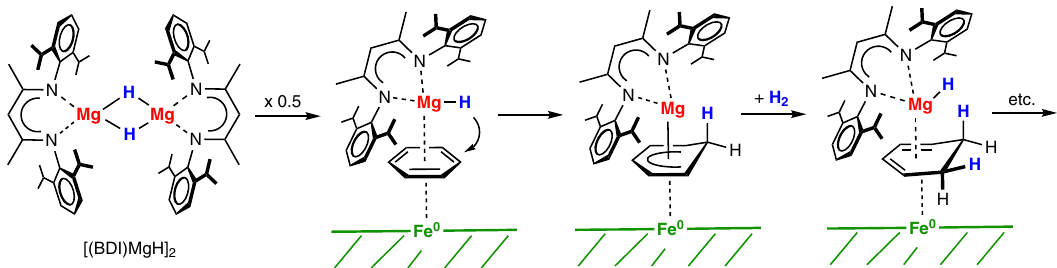
Fig. 5 Proposed mechanism for cooperative benzene hydrogenation. Benzene, activated at a Fe 0 surface, is hydrogenated by a soluble Mg hydride